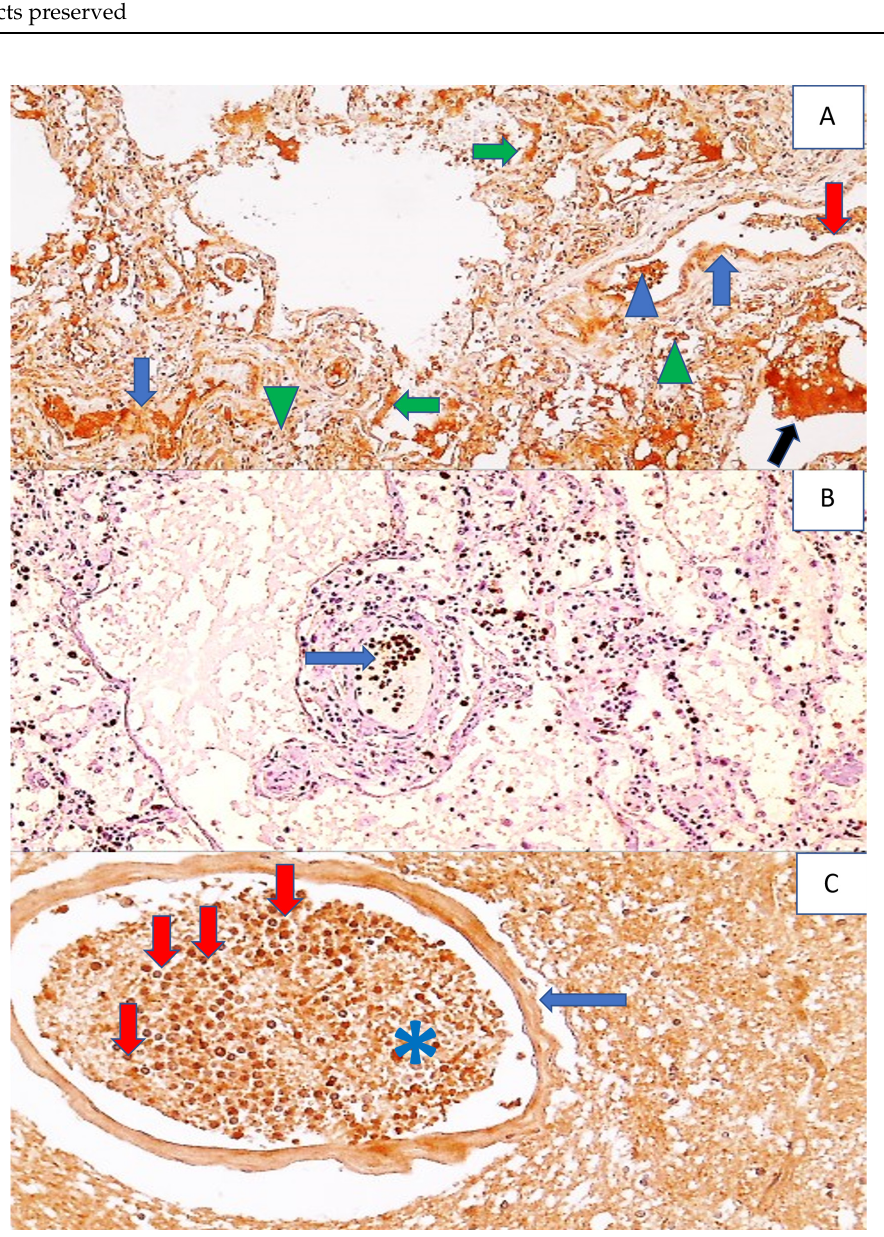
Figure 6. Immunohistochemistry for 4-HNE protein adducts and MPO in the lungs and 4-HNE protein adducts in the brain of a COVID-19 patient. Photo ( A ) shows the immunohistochemically positive reaction to 4-HNE in the pulmonary blood vessel walls (blue arrows) and in the content of the blood vessel (red arrow), in the edematous fluid in the alveoli (black arrow) and hyaline mem- branes (green arrows), in some inflammatory cells in the blood vessels (blue arrowheads), and in alveolar macrophages (green arrowheads), (DAB, 100×). Photo ( B ) shows an immunohistochemi- cally positive reaction to MPO, exclusively in neutrophils that are mainly in the blood vessels of the lungs (arrow) and rarely outside them in the lung tissue, presented as dark brown spots, (DAB, 200×). Photo ( C ) shows a strong immunopositive reaction to 4-HNE in a blood vessel wall (arrow), in the content of blood vessels (asterisk), especially in the neutrophils within the blood vessel (red arrows), while being sparsely present in the surrounding edematous brain tissue, visi- ble as dark brown cells (DAB, 400×).